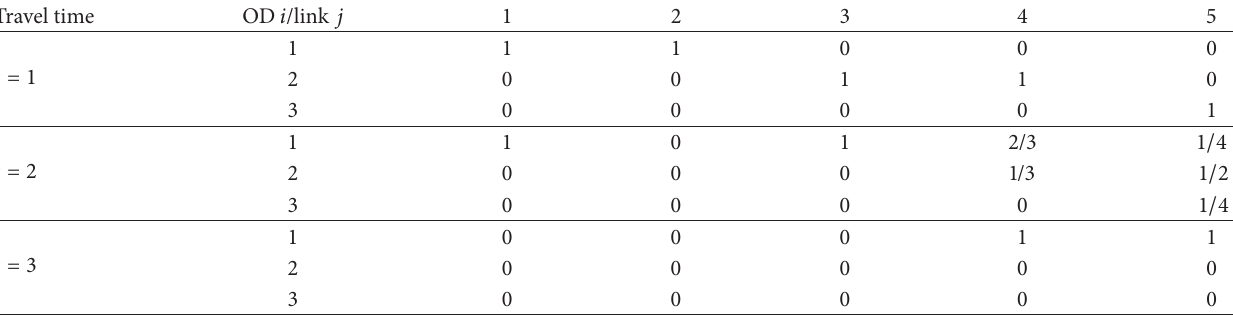
Table 9: Probe ratio assignment matrix